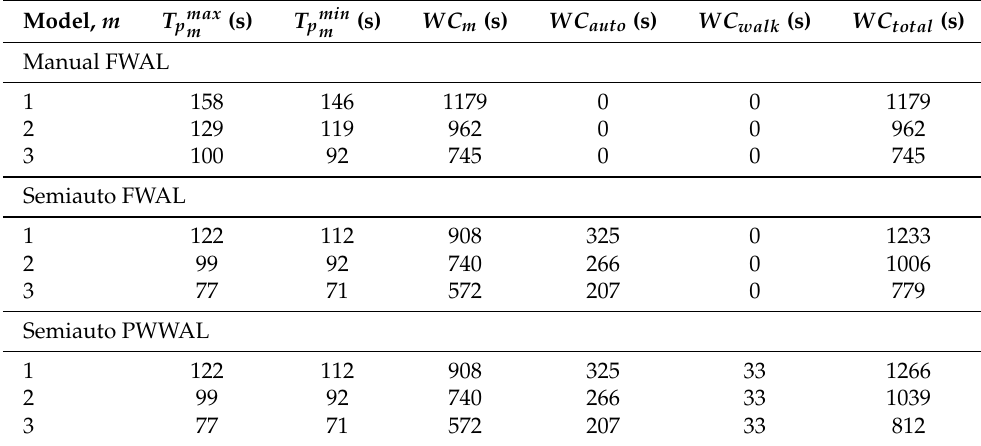
Table 3. Manual processing times and work content input data.